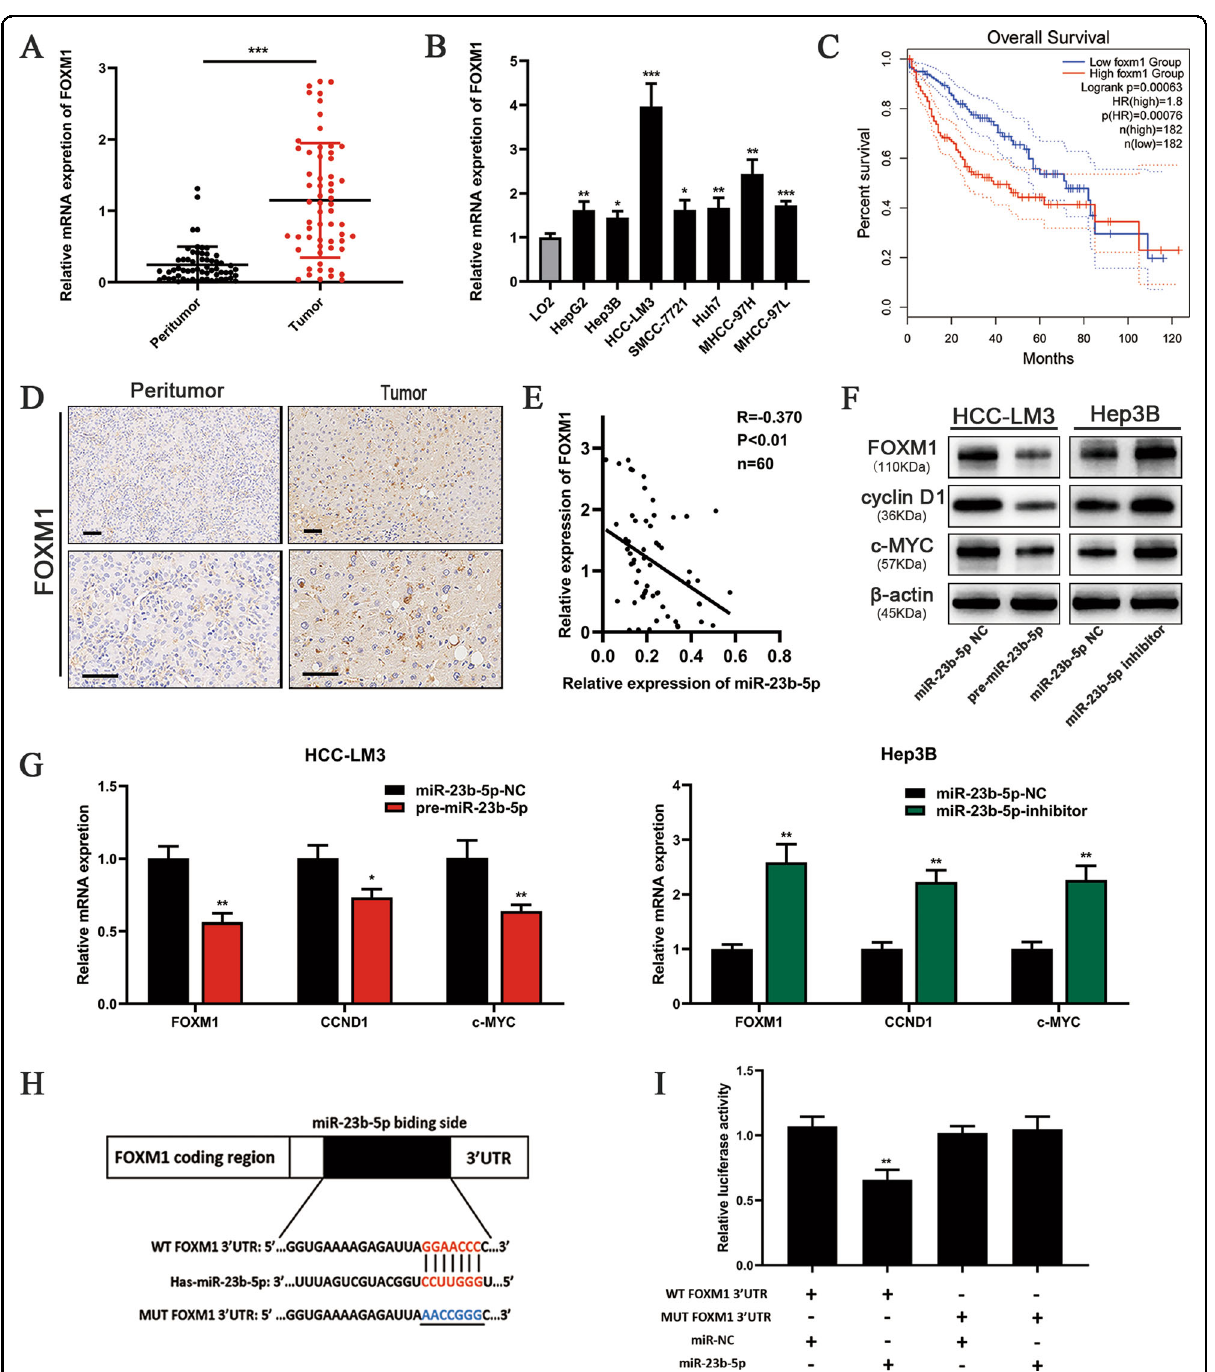
Fig. 3 FOXM1 is upregulated in human HCC tissues and cell lines and miR-23b-5p directly targets FOXM1 in HCC cells. A , B Expression levels of FOXM1 in the HCC tissues and cell lines were detected by qRT-PCR. C Kaplan – Meier analysis for overall survival of patients with HCC according to FOXM1 expression level in all patients (GEPIA database). D Representative immunostaining images of FOXM1 in HCC tissues and adjacent normal tissues (scale bars, 50 μ m). E Spearman correlation analysis con fi rmed the correlations between the FOXM1 mRNA and miR-23b-5p expression levels in the 60 HCC samples ( r = − 0.370, P <0.01). F , G Western blotting and qRT-PCR analysis of the expression levels of FOXM1, CCND1, and c-MYC in the HCC-LM3 cells transfected with miR-23b-5p-NC or pre-miR-23b-5p and the Hep3B cells transfected with miR-23b-5p-NC or miR-23b-5p-inhibitor. H The predicted miR-23b-5p targeting sequence in the FOXM1 3 ′ -UTR (WT FOXM1 3 ′ UTR). The target sequences of the FOXM1 3 ′ UTR were mutated (MUT FOXM1 3 ′ UTR). I Dual-luciferase reporter assay of the cells transfected with WT FOXM1 3 ′ UTR or MUT FOXM1 3 ′ UTR reported together with 40nM of the miR-23b- 5p mimic or negative control oligoribonucleotides. All data are presented as the mean ± S.E.M. (* P <0.05, ** P <0.01, and *** P